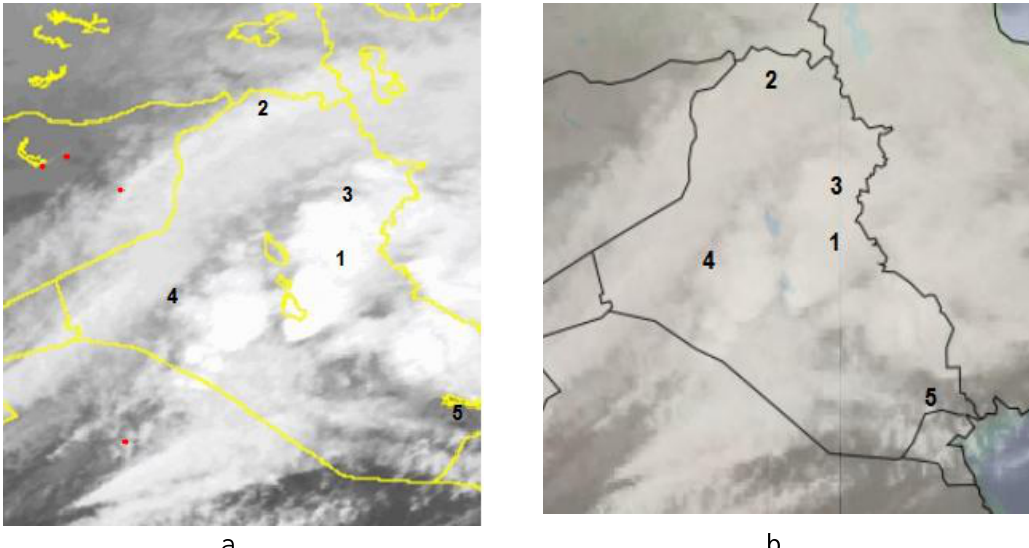
Fig. 11: a) Infrared meteosat satellite image, b): Infrared goes satellite